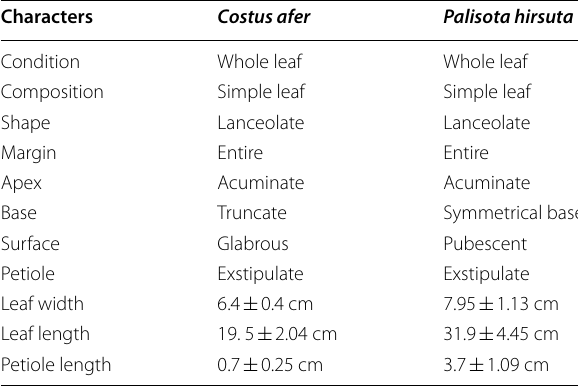
Table 1 Macroscopy of Costus afer and Palisota hirsuta